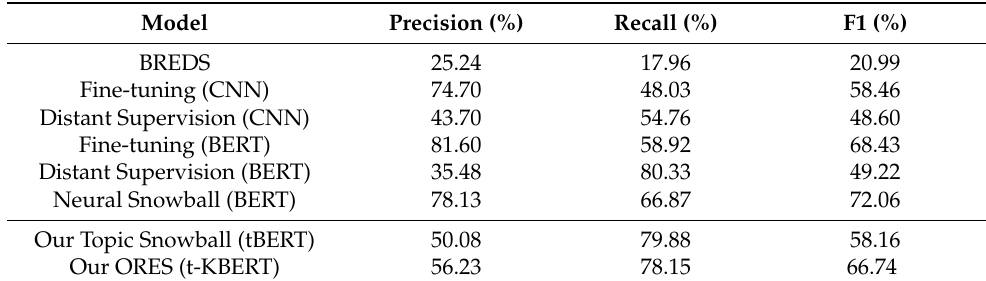
Table 3. The 15-shot experimental results on various previous baseline